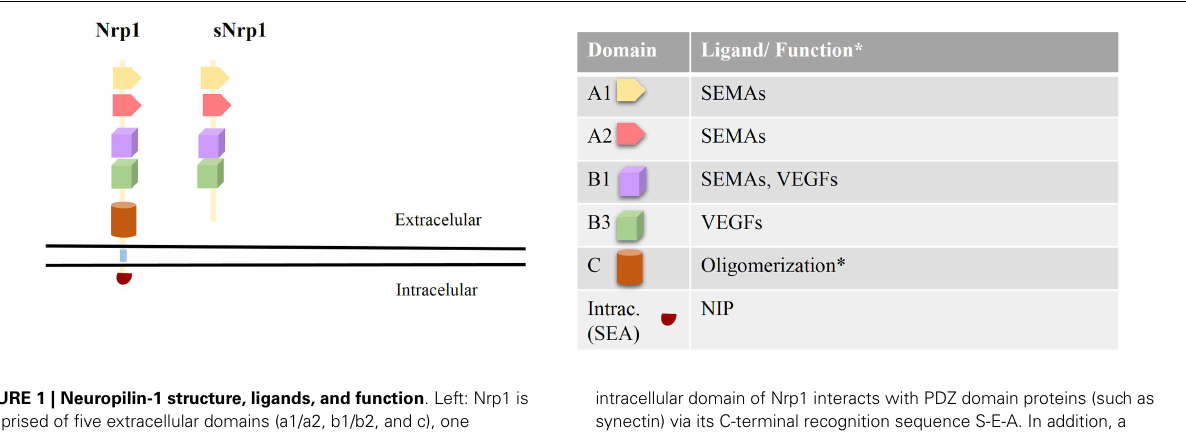
intracellular domain of Nrp1 interacts with PDZ domain proteins (such as synectin) via its C-terminal recognition sequence S-E-A. In addition, a natural-occurring soluble form of Nrp1 (sNrp1), lacking the c- and transmembrane domains, is shown. Right: the function and ligand binding properties of each Nrp1 domain is